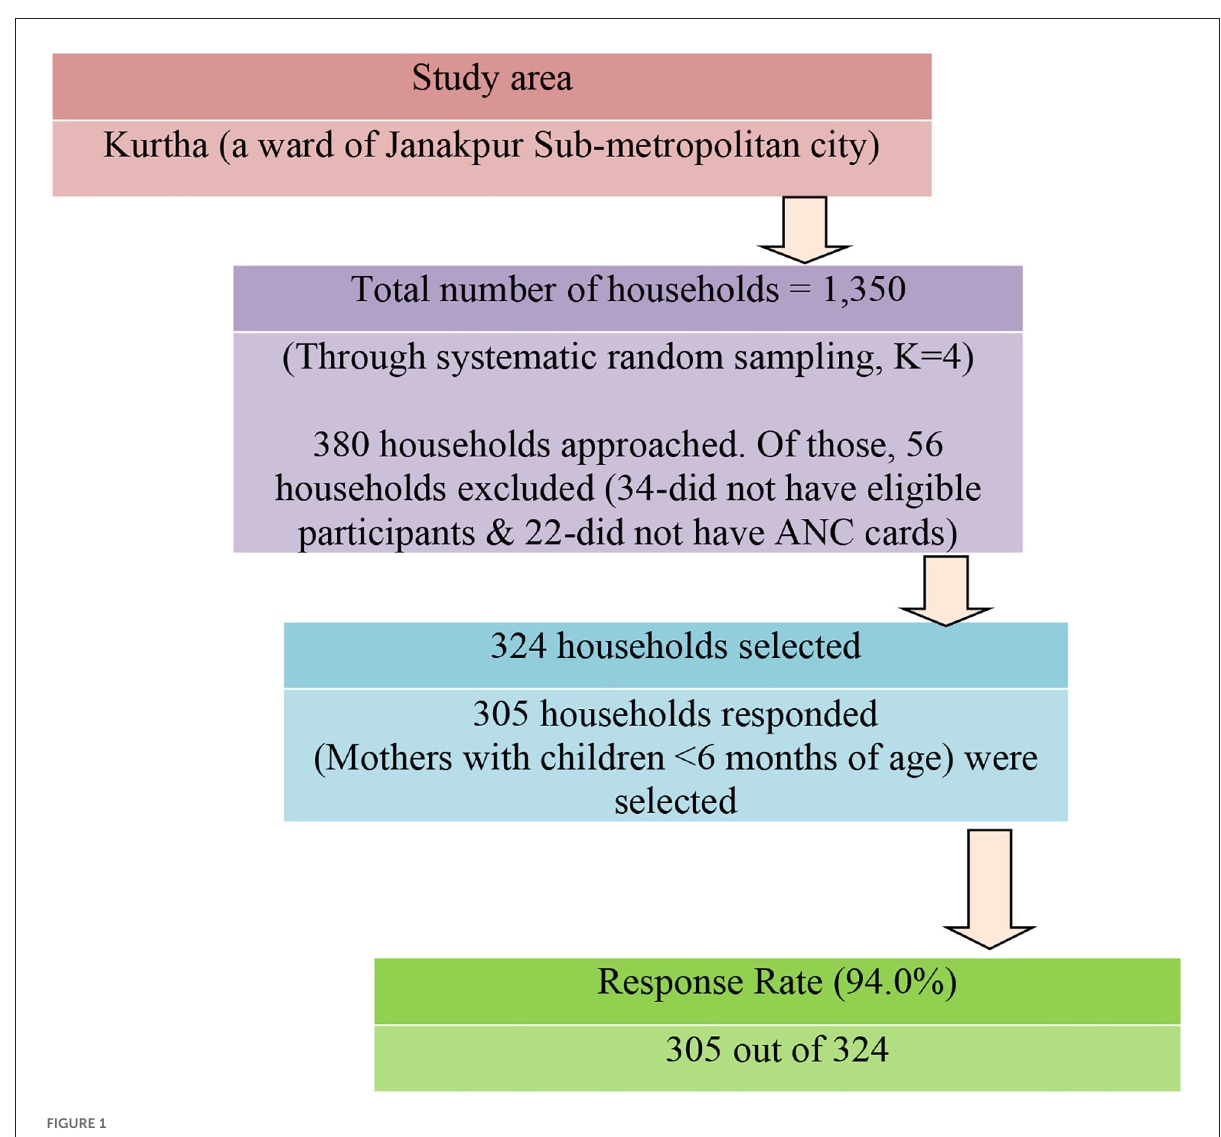
FIGURE1 Sampling